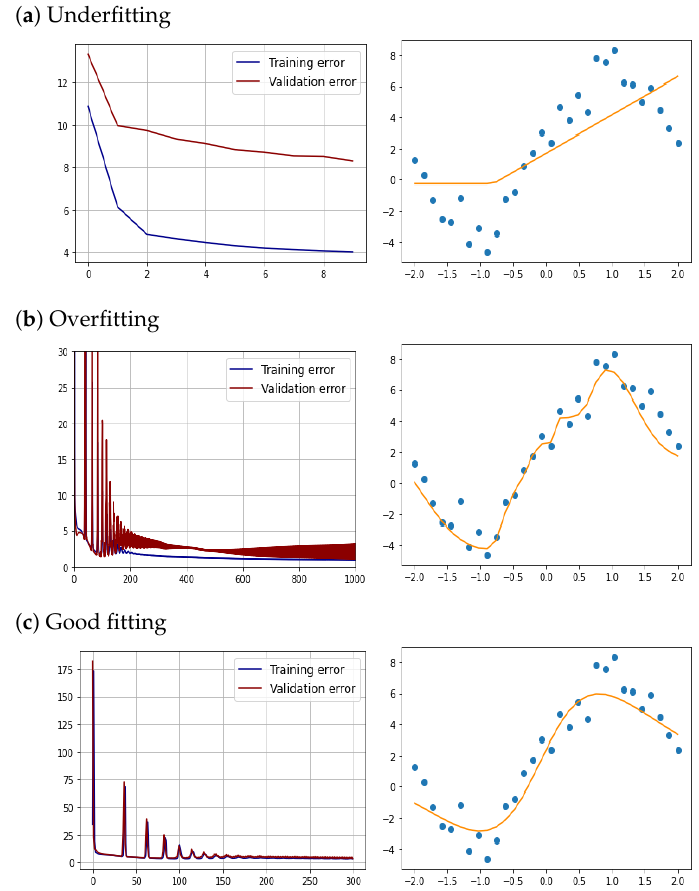
Figure 3. Comparison between different training processes and how we can infer information about model performance by plotting epochs ( x -axis) with training and validation error. ( a ): the model was trained with too many epochs, and while the training error converges to zero, the validation error oscillates and the model was too well adapted to the training set that it is unable to generalise. ( b ): the difference between the training curve and the validation is minimal, both converge to zero and the number of epochs is appropriate enough. A good model does not give up on training data, but emulates it well and can be generalised to more elements of the distribution. ( c ): the difference between the training curve and the validation is minimal, both converge to zero and the number of epochs is appropriate enough; a good model does not give up on training data, but emulates it well and can be generalised to more elements of the